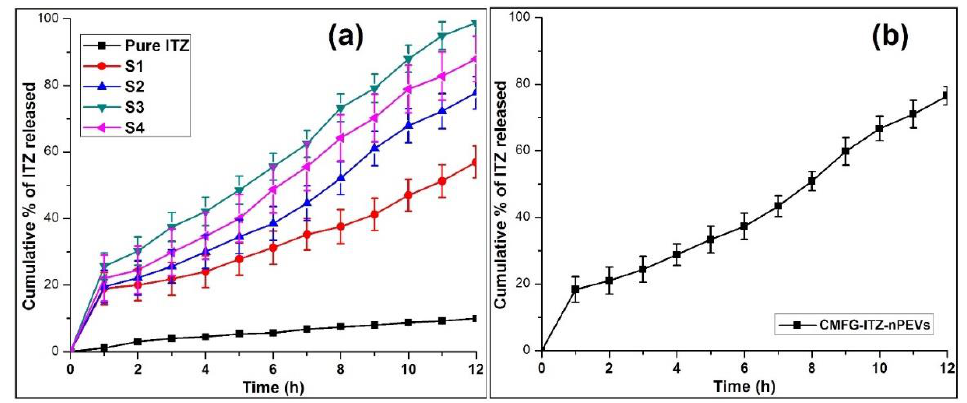
Figure 2. In vitro release of ITZ from ( a ) pure drug, S1-S4 ITZ-nPEVs, and ( b ) CMFG-ITZ-nPEVs (Mean ± SD).